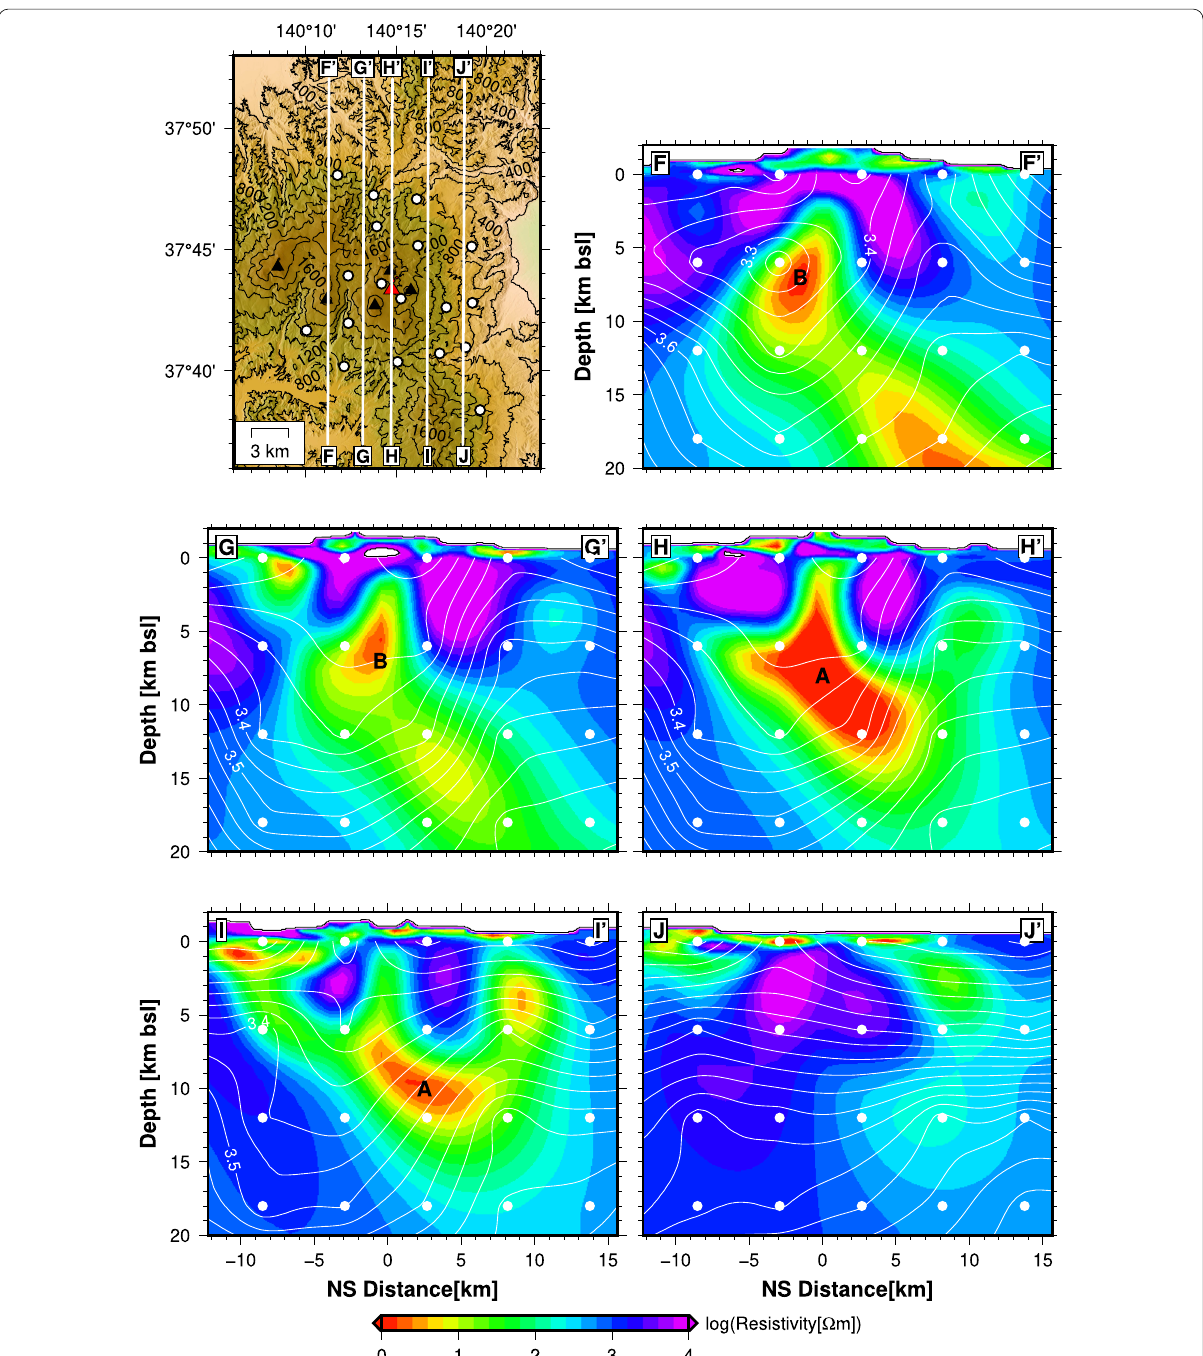
Fig. 17 Vertical profiles of the V s model by Okada et al. (2015) superimposed on the resistivity model (Fig. 7) in the N–S direction. Other features are the same as those in Figs. 7 and